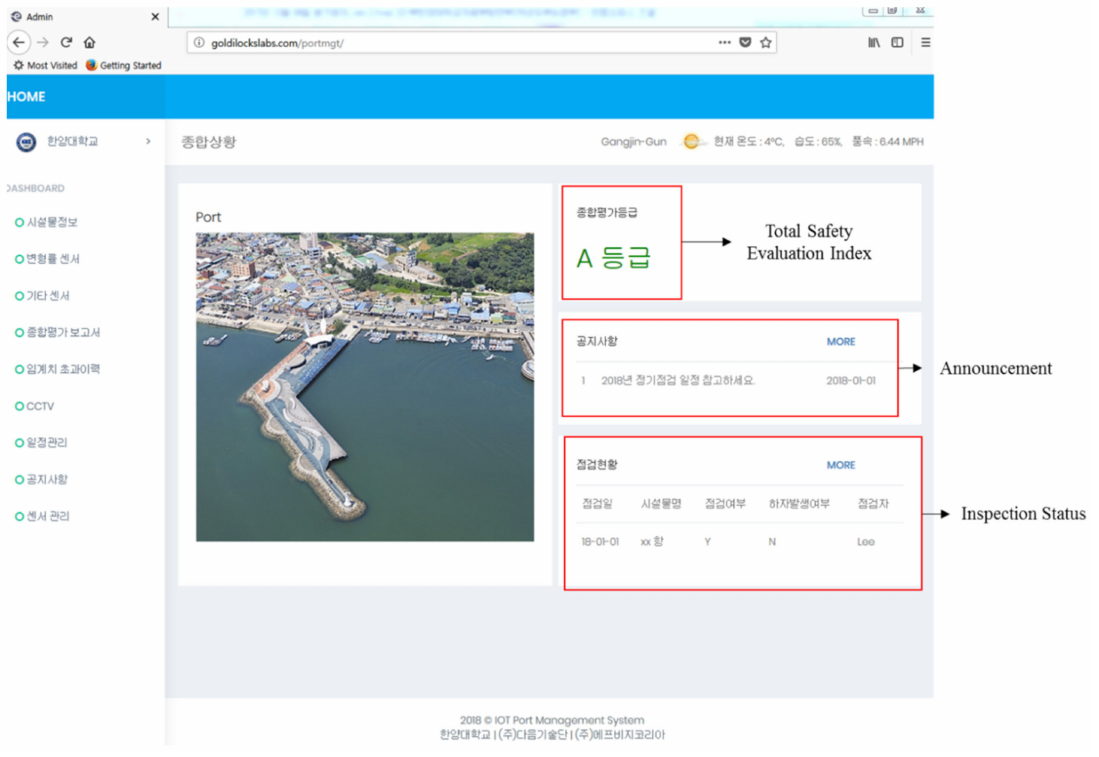
Figure 12. Main page of the web